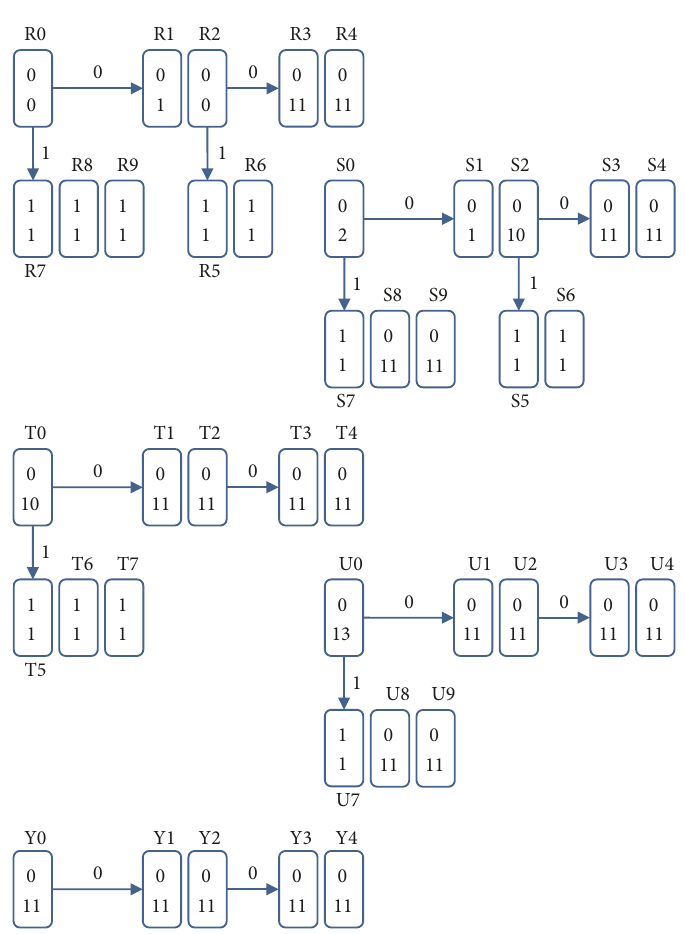
Figure 3: Iteration of time period